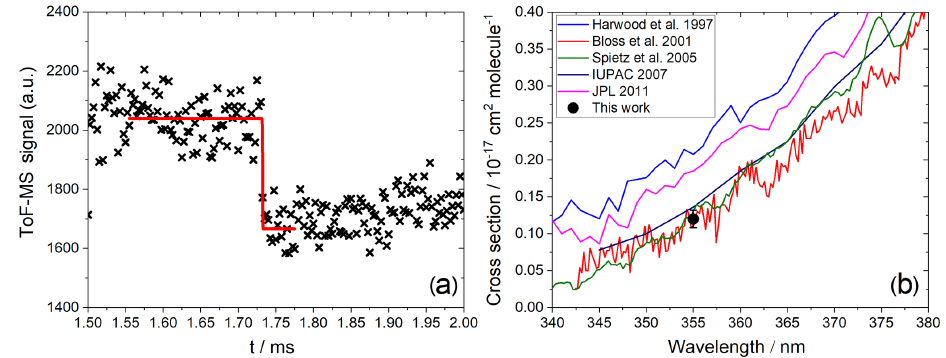
Figure 6. (a) Measured photodepletion of IO ( m/z = 143). (b) Comparison of a published absorption cross section with the absorption cross section at 355nm determined in this work.